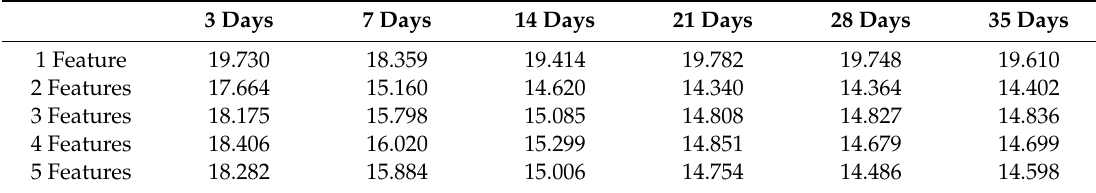
Table 3. NRMSE calculations for Plant